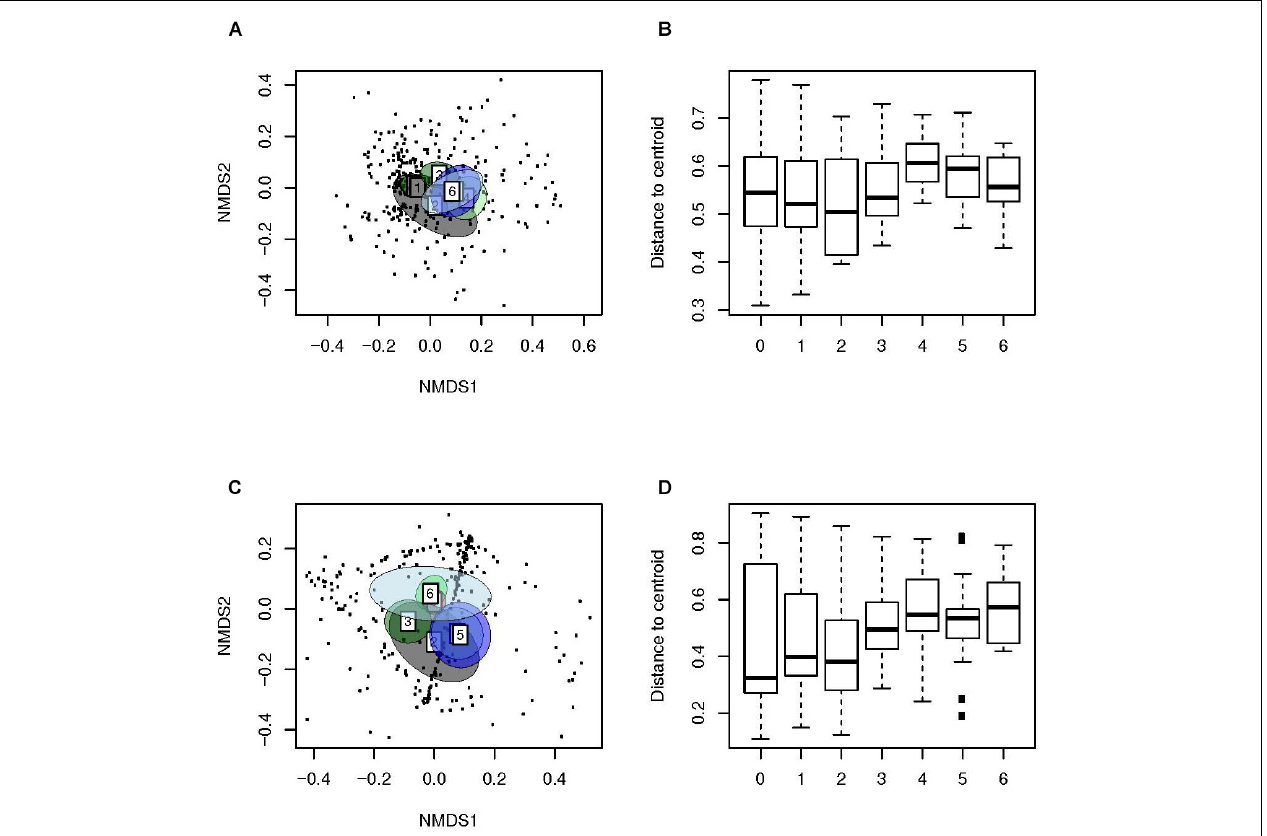
FIGURE 3 | Beta-diversity analyses of samples of children with AOM suggest a more personalized bacterial microbiota with age. Illustrated are (A) Weighted (Ružiˇcka) and (C) unweighted (Jaccard) distances in microbiota composition, reduced in a 2D-space by using NMDS, 95% confidence ellipse for the group centroid shown. In addition, shown are the beta-dispersion based on (B) Ružiˇcka and (D) Jaccard dissimilarity indices in each sample type. The boxplots represent median (midline), interquartile ranges (shaded boxes), and ranges (whiskers). Data is shown according to the age (years) of the children with